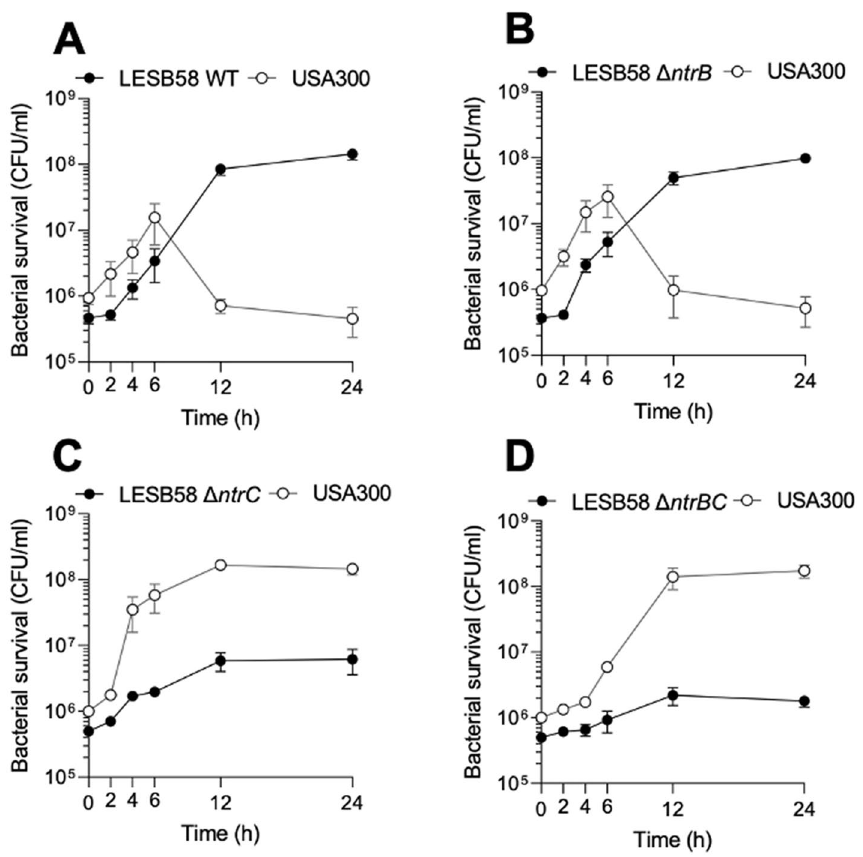
Figure 3. P. aeruginosa LESB58 outcompeted S. aureus USA300 LAC in an NtrC-dependent manner. P. aeruginosa LESB58 ( A ) WT, ( B ) Δ ntrB , ( C ) Δ ntrC or ( D ) Δ ntrBC mutant strains were seeded at a starting OD 600 = 0.1 in batch cultures that were sampled at two, six or 12 h intervals and plated on selective media for bacterial enumeration. Data are presented as mean ± standard error of the mean (SEM) for three independent experiments ( n =